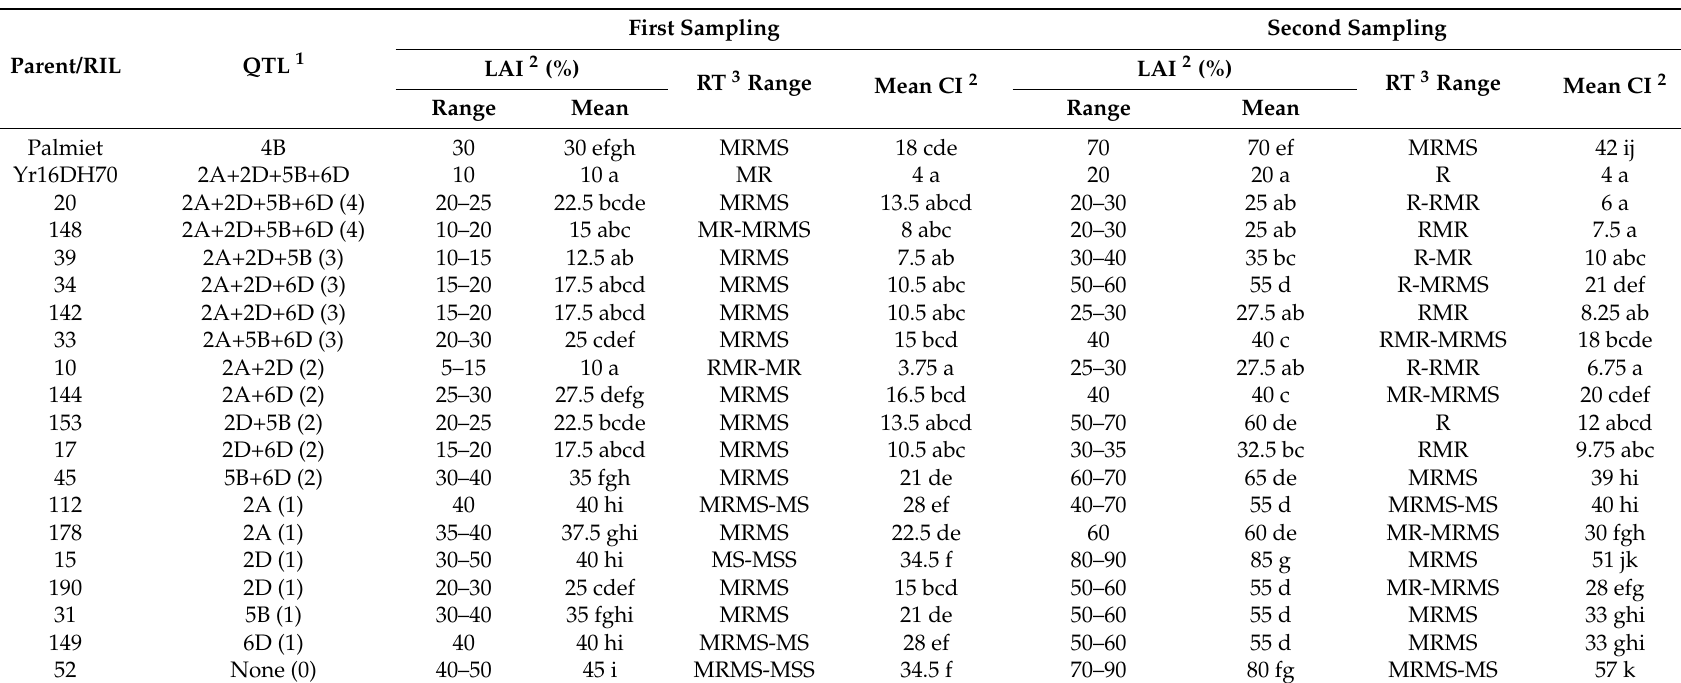
Table 1. Leaf area infected (LAI), host reaction type (RT) and coefficient of infection (CI) of F 8 Palmiet × Yr16DH70 recombinant inbred lines (RILs), including the parents Palmiet and Yr16DH70, after infection with Puccinia striiformis f. sp. tritici race 6E22A+.